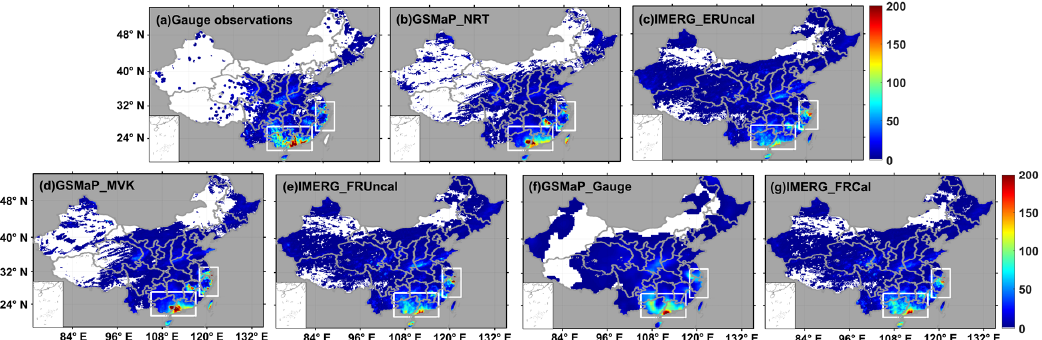
Figure 2. Spatial distribution of 72 h of accumulated precipitation during typhoon Mangkhut over Mainland China as measured by ( a ) gauge observations, ( b ) GSMaP_NRT, ( c ) IMERG_ERUncal, ( d ) GSMaP_MVK, ( e ) IMERG_FRUncal, ( f ) GSMaP_Gauge, and ( g ) IMERG_FRCal: white rectangles indicate the rainfall center.